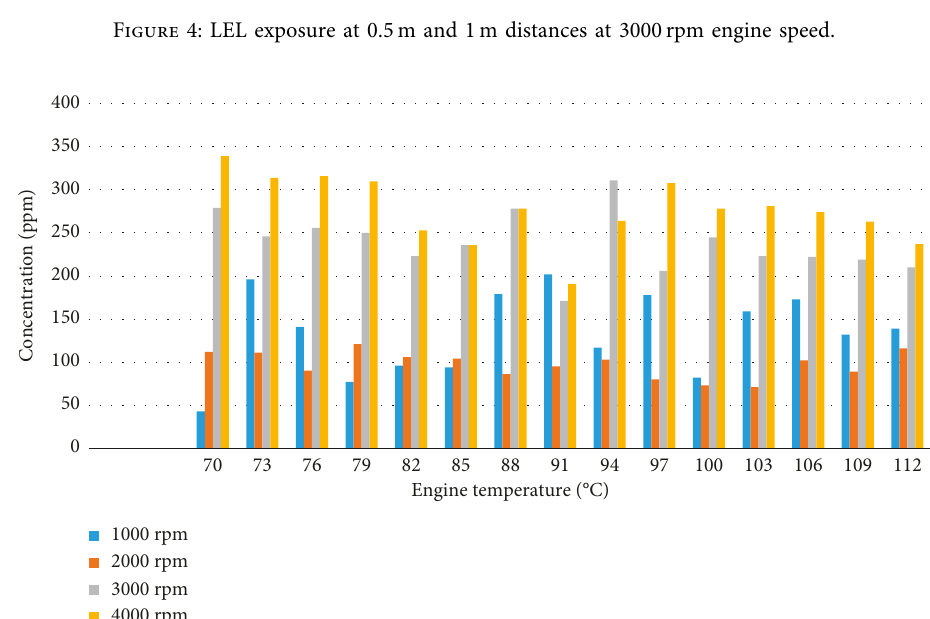
Figure 5: CO exposure at 1m distance for different engine speeds for gasoline +H